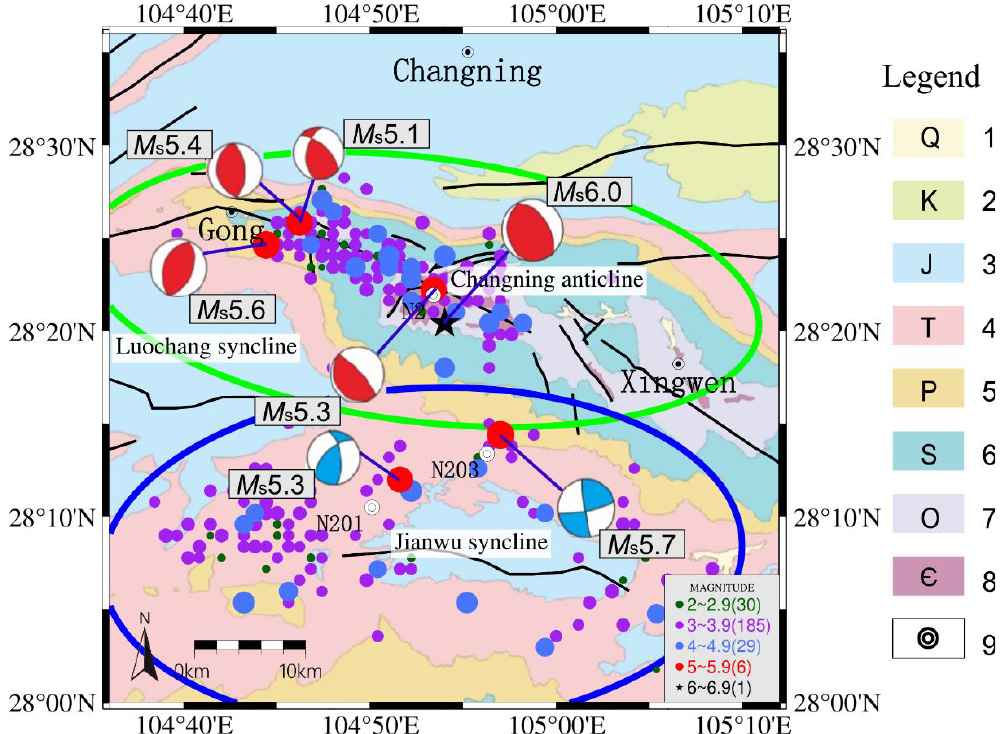
Figure 2. Distribution characteristics of earthquakes and geological settings (modified from [13]) in the Changning area. The focal mechanism plots indicate the focal mechanism solutions of moderate earthquakes; red is in the Changning anticline, and blue is in the Jianwu syncline [13]. The two ellipses are earthquake clusters [6]. The black lines represent the fault line in the Changning area, including tectonic lines and surveyed faults [5,17]. The magnitude numbers are shown in the lower right corner. Different colors represent different earthquake magnitudes. The earthquake catalog is from 2012.03 to 2022.03. Legend: 1, Cenozoic; 2, Cretaceous; 3, Jurassic; 4, Triassic; 5, Permian; 6, Silurian; 7, Ordovician; 8, Cambrian; 9, drilling well.